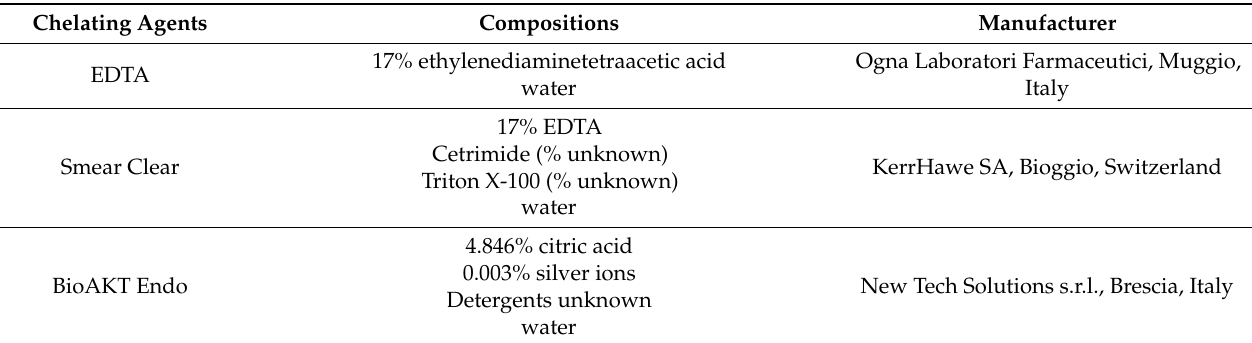
Table 1. Chelating agents’ compositions and